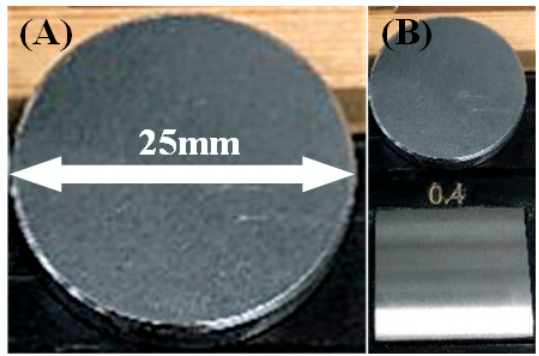
Figure 2. 45# steel samples. ( A ) diameter; ( B ) average surface roughness.